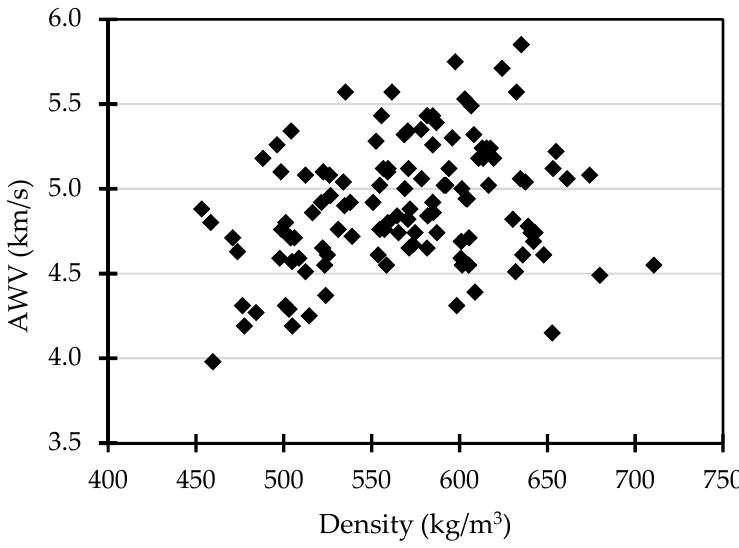
Figure 7. Density versus acoustic wave velocity distribution of the fibre-managed E. nitens timber boards .